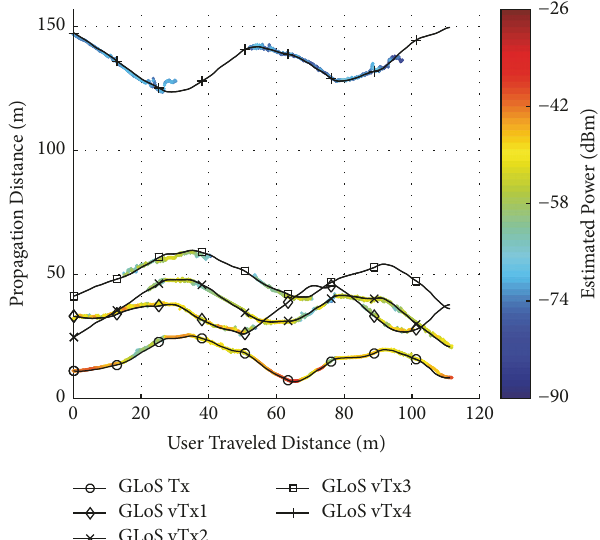
Figure 10: The results of the KEST estimator for the outdoor measurements showing the propagation distances, that is, the ToAs multiplied by the speed of light, of signal components, versus the user traveled distance. Only signal components that are observable for long traveled distance are shown. The color indicates the estimated received power for the signal components in dB.